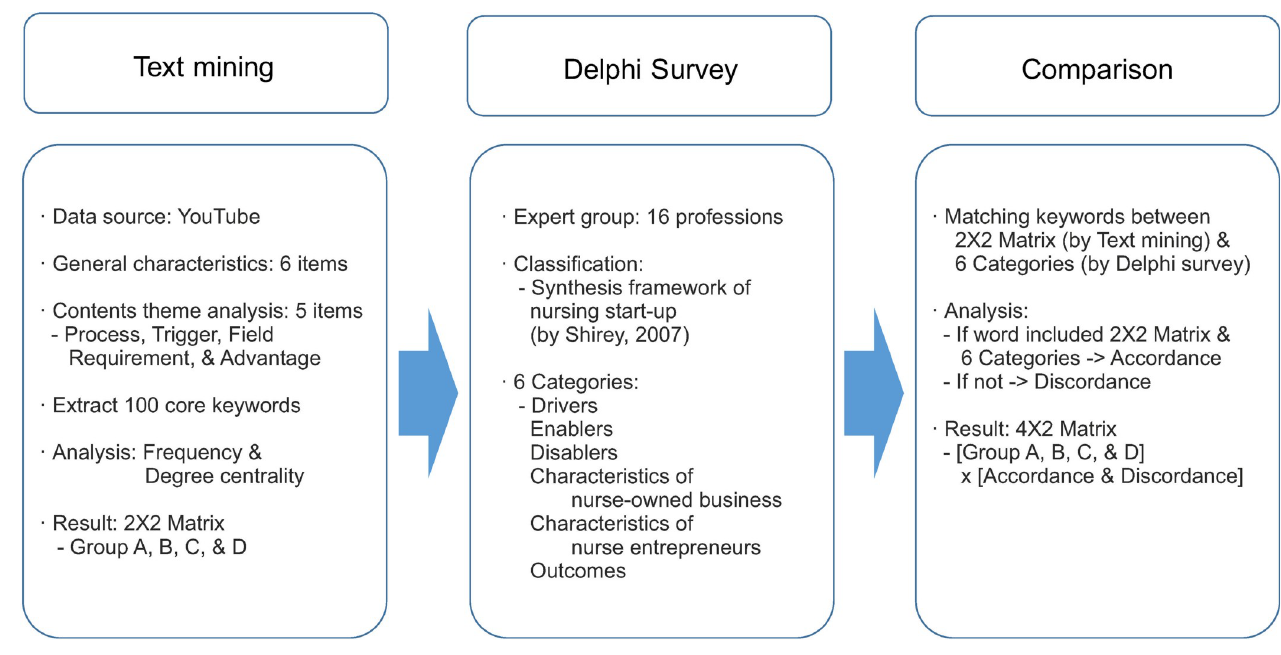
Fig 1. Flow of this